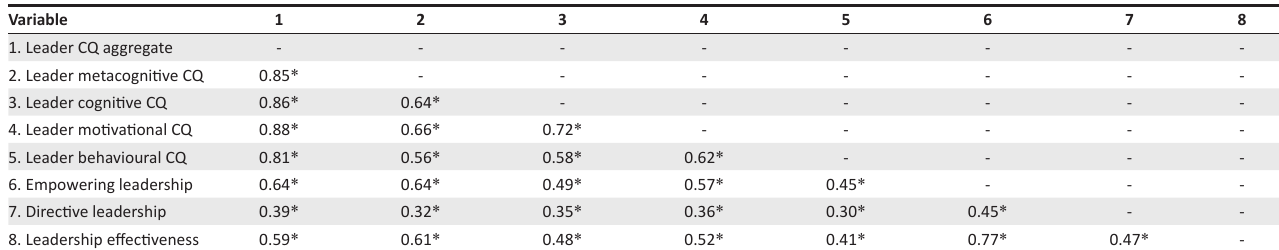
TABLE 6: Correlations.